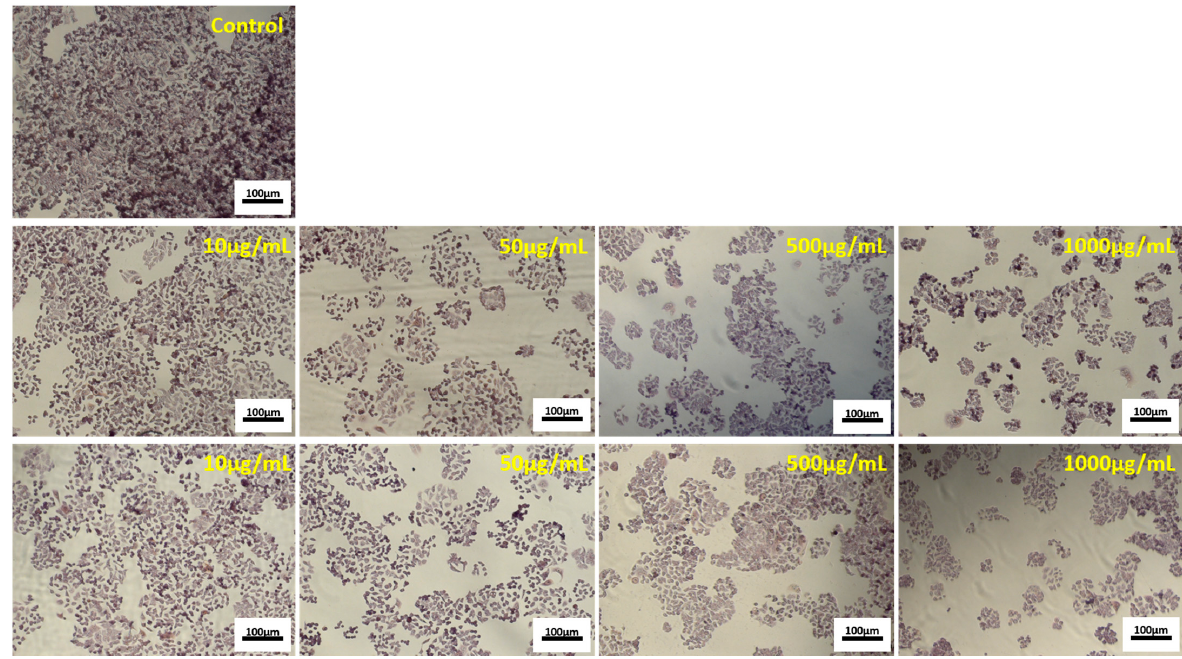
Figure 4. Representative light micrographs of HT-29 cells cultivated in the presence of different concentrations of P40 (second line) and P45 (third line) microencapsulated materials, for 48 h. The untreated culture served as control (first line). (Giemsa staining). Bar scale = 100 µm.